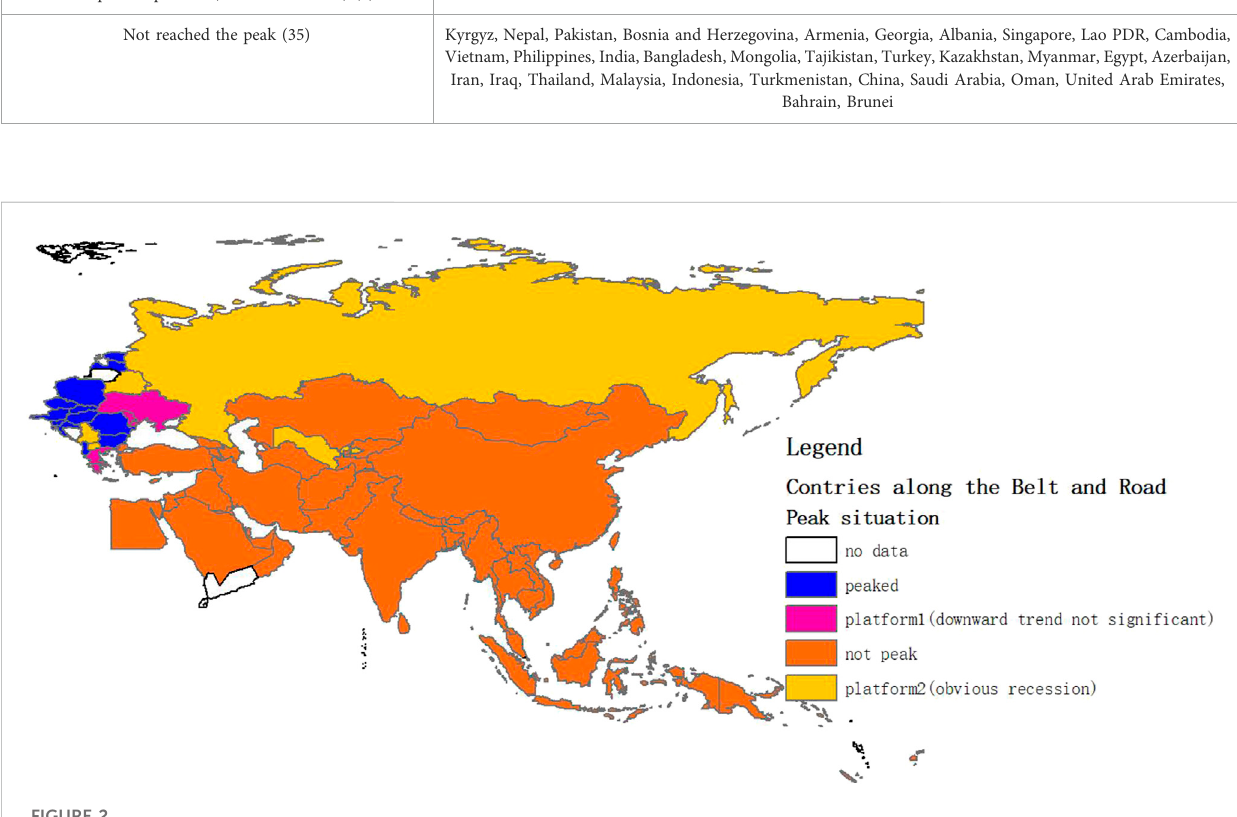
FIGURE 2 Country distribution map of different peak